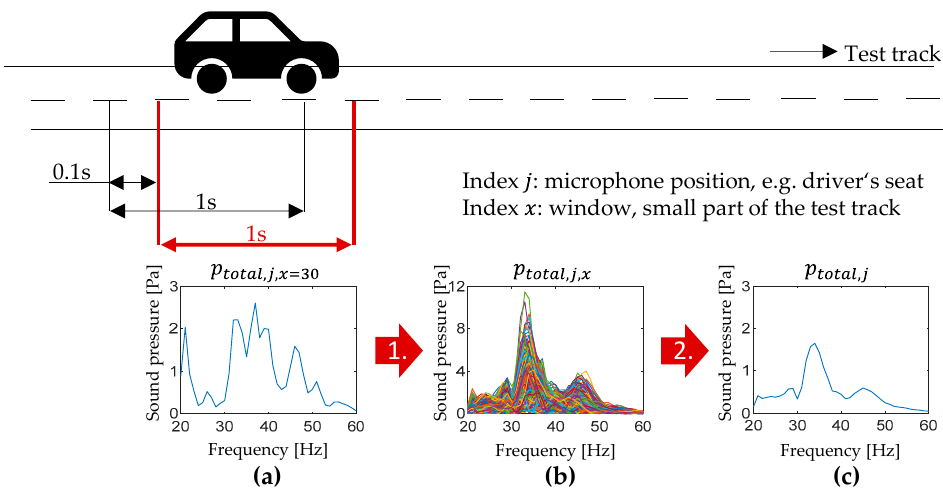
Figure 1. Method for calculating the sound pressure in the interior of a vehicle when driving over a test track, using a time segmentation of the excitation load approach: ( a ) Calculated sound pressure of one section; ( b ) Calculated sound pressure of all sections of the test track; ( c ) RMS average of all calculated sound pressures of all sections.